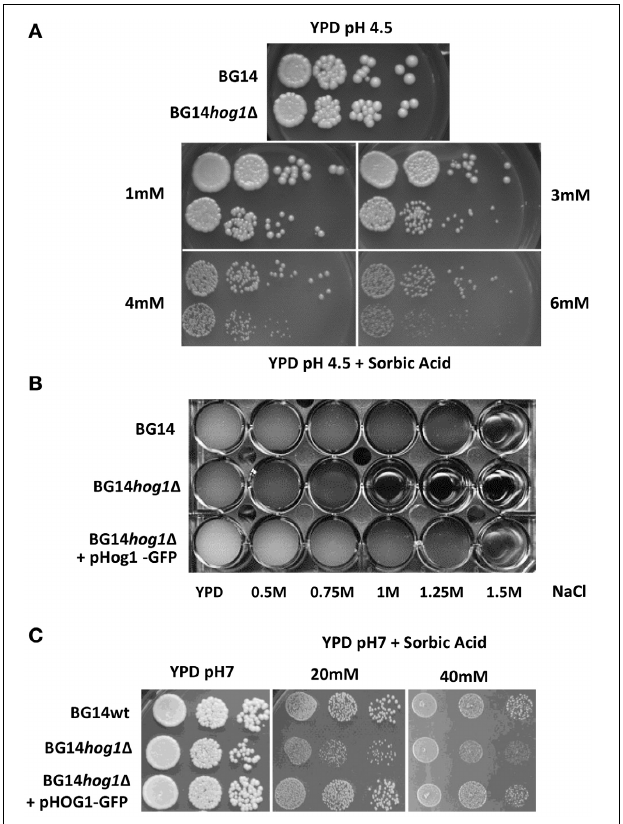
FIGURE 2 | (A) C. glabrata mutants deleted for HOG1 display sensitivity to weak acids. Cultures of the C. glabrata strains BG14 and BG14 hog1 (cid:2) , were diluted and spotted onto rich medium containing the indicated amounts of sorbic acid at pH 4.5. Growth was recorded after about 36h for the control and 48 for weak acid stress. (B) CgHog1-GFP complements the osmotic stress sensitivity of the BG14 hog1 (cid:2) strain. Cultures of BG14, BG14 hog1 (cid:2) and BG14 hog1 (cid:2) transformed with CgHog1-GFP were diluted to OD 600 of 0.01 in YPD and exposed to a range of NaCl concentrations. Growth was recorded after 24h. (C) CgHog1 is required for growth under sorbic acid stress. Cultures of wild type and BG14 hog1 (cid:2) cells with and without CgHog1-GFP were diluted and spotted onto medium containing the indicated amounts of sorbic acid at neutral pH. CgHog1-GFP complements the growth defect of BG14 hog1 (cid:2) under sorbic acid stress. Growth was recorded after 36h of incubation.